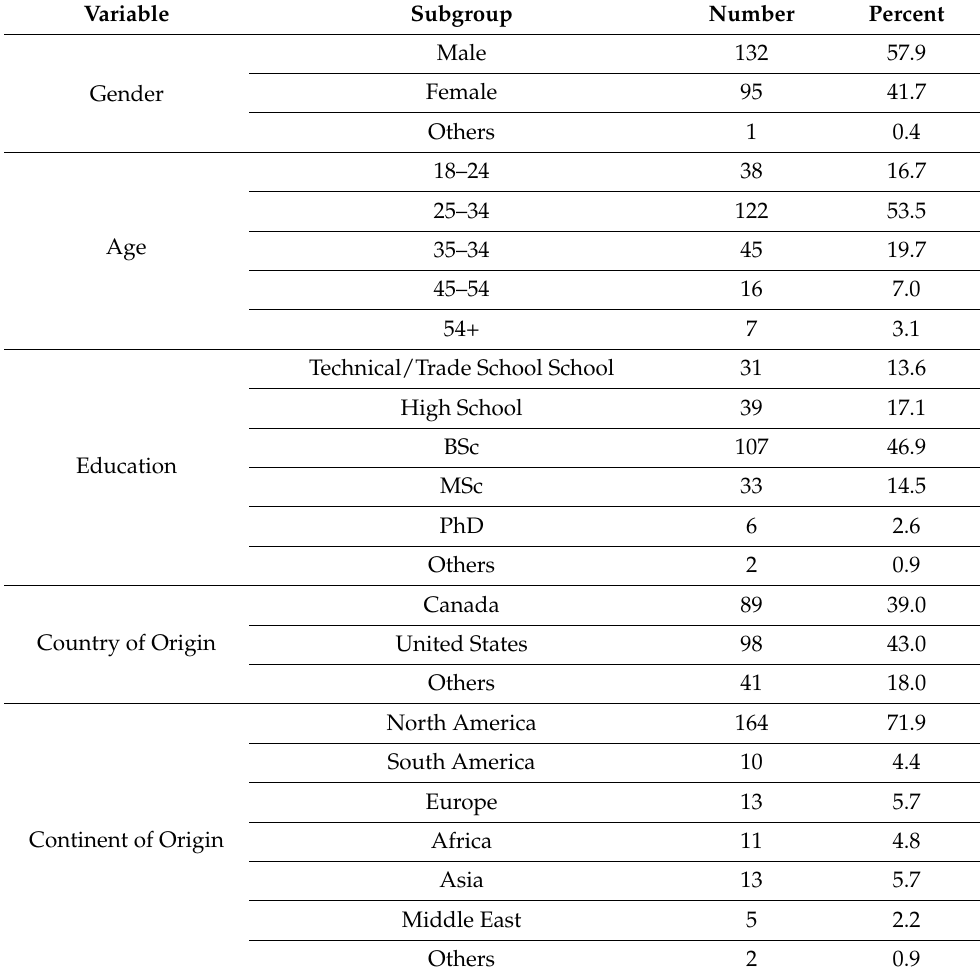
Table 4. Demographics of participants ( n =